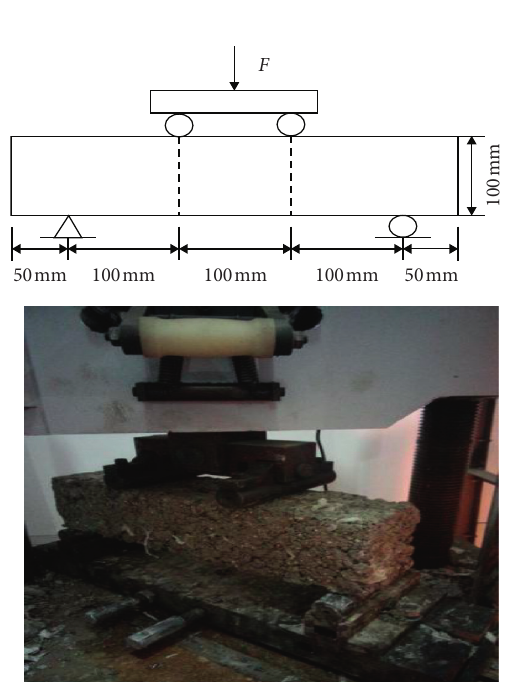
Figure 7: Sketch map of flexural-tensile strength test.